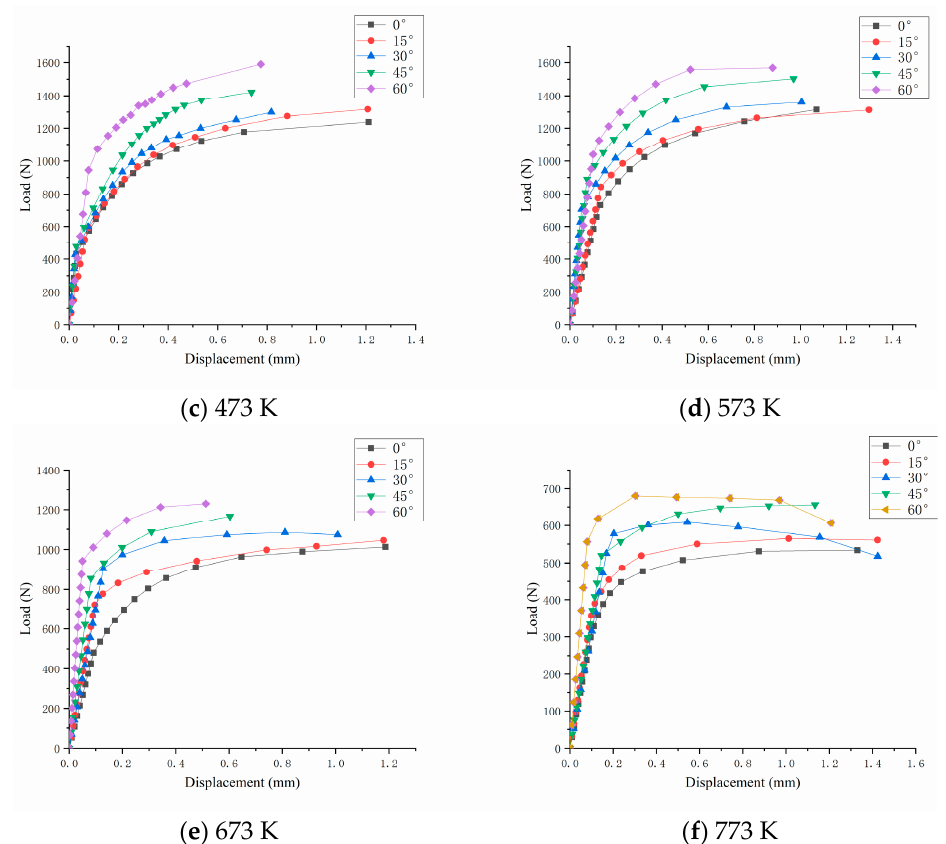
Figure 6. Load–displacement curves of shear specimens at different temperatures ( a – f ).